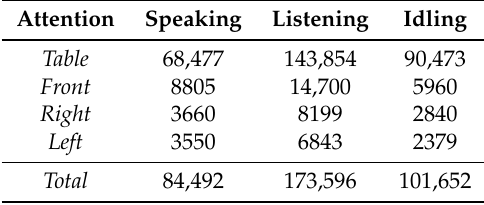
Table 2. Distribution of data instances regarding attention targets and situations. Attention Speaking Listening Idling